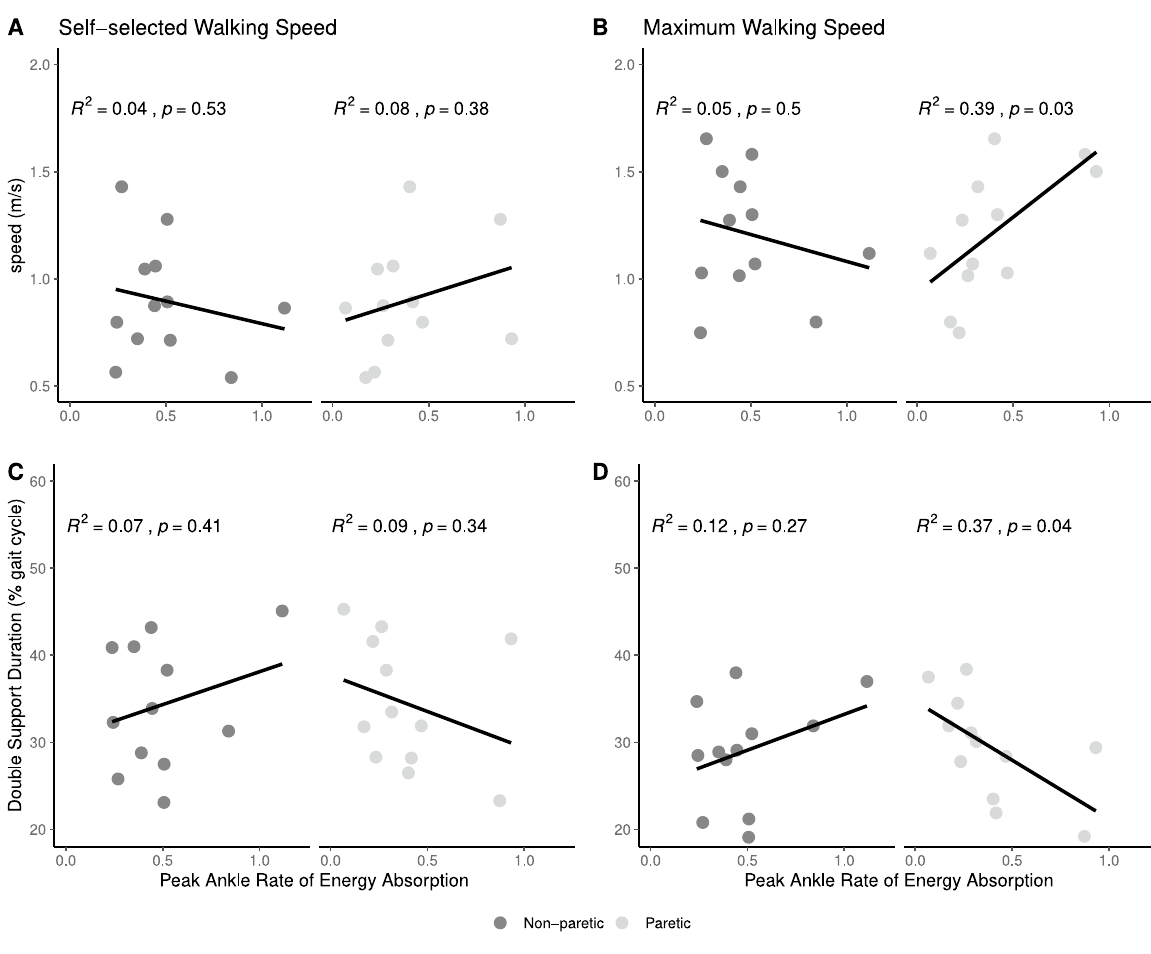
Figure 7. Relationships between peak ankle rate of energy absorption during imposed limb loading assessment and self-selected walking speed ( A ), maximal walking speed ( B ), double support duration during self-selected walking speed ( C ), and double support duration during maximal walking speed ( D